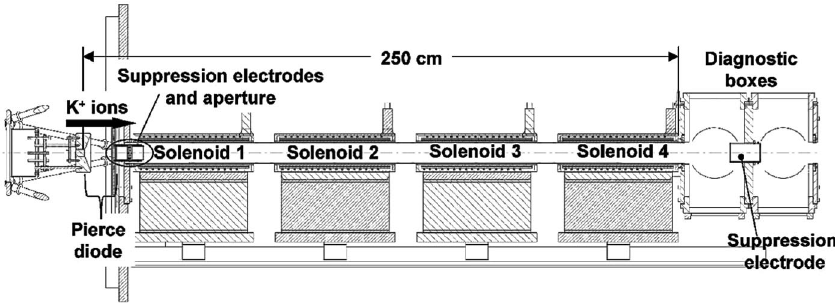
FIG. 1. Elevation view of the four-solenoid